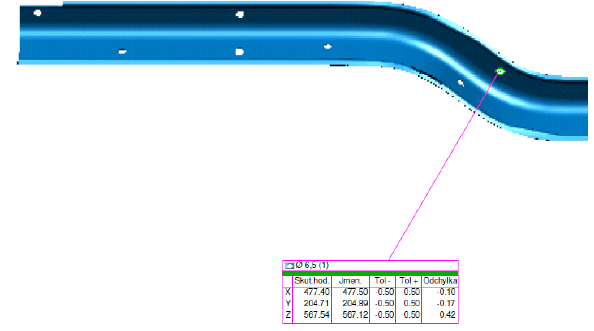
Figure 1: Graphical output from the measuring instrument